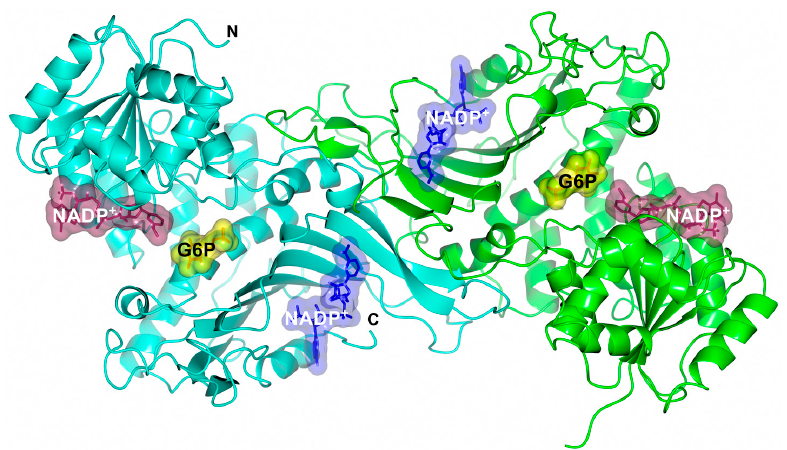
Figure 1. Dimeric arrangement of human G6PD enzyme (PDB entries 2BHL and 2BH9). Monomers are drawn in cyan and green. The structural NADP + , catalytic NADP + and G6P substrate are shown as blue, dark purple and yellow molecular surface representations, respectively. All figures were prepared with CCP4mg (Didcot, UK) [11] using the same color code.